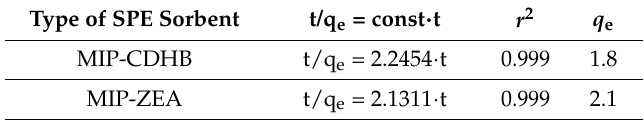
Table 6. Second order kinetic results for adsorption of ZEA by